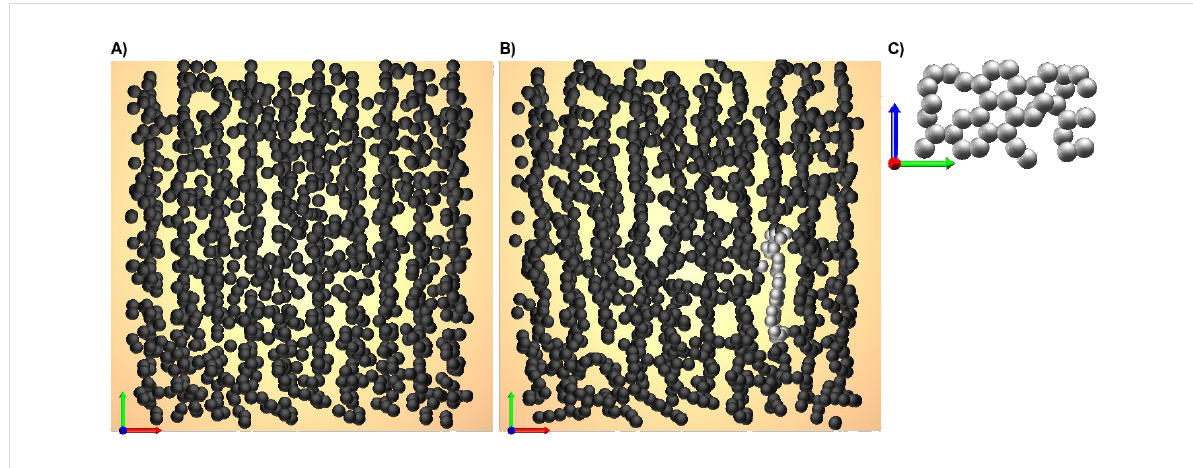
Figure 4: Top view of a strongly excited initial state (A) and of the corresponding local energy minimum state (B). (C) shows the side view of the high- lighted region in (B).